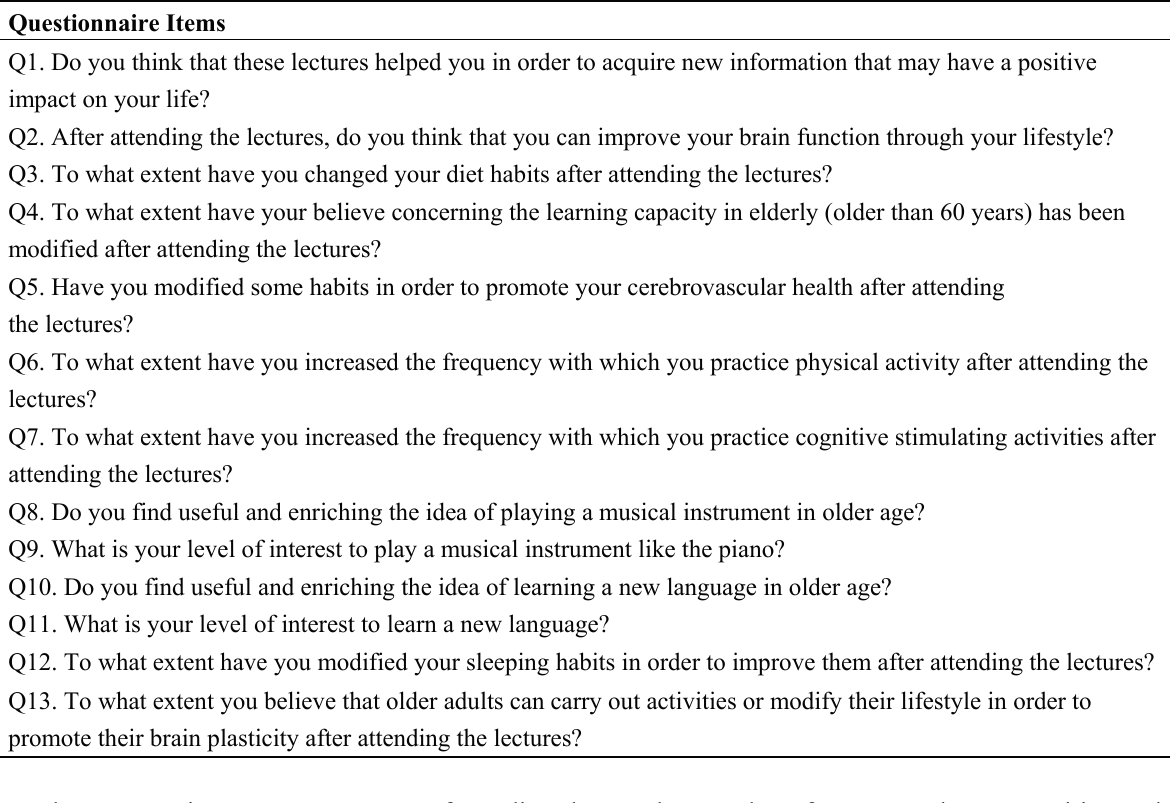
Table 2. The 13 multiple choice questions included in the questionnaire in order to assess the impact of the lectures on behavioral changes towards a healthy lifestyle, the knowledge of participants concerning brain health, and their motivation to practice cognitively stimulating activities as learning a musical instrument or new